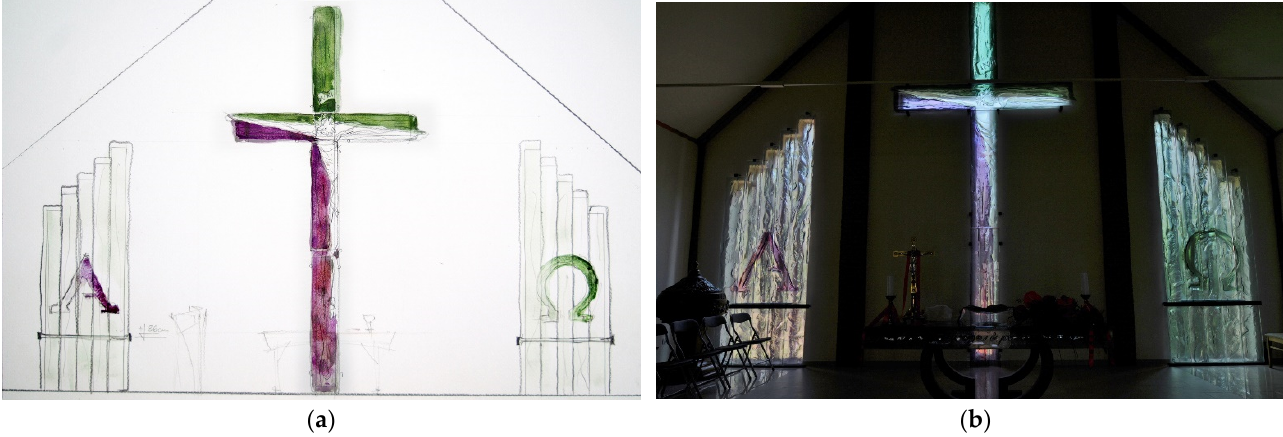
Figure 16. Glass design by Tomasz Urbanowicz for the Church of the Savior of the Parish of the Evangelical Church of the Augsburg Confession in Działdowo, Poland, 2008: ( a ) watercolor project; ( b ) glass-art realization (Tomasz Urbanowicz).